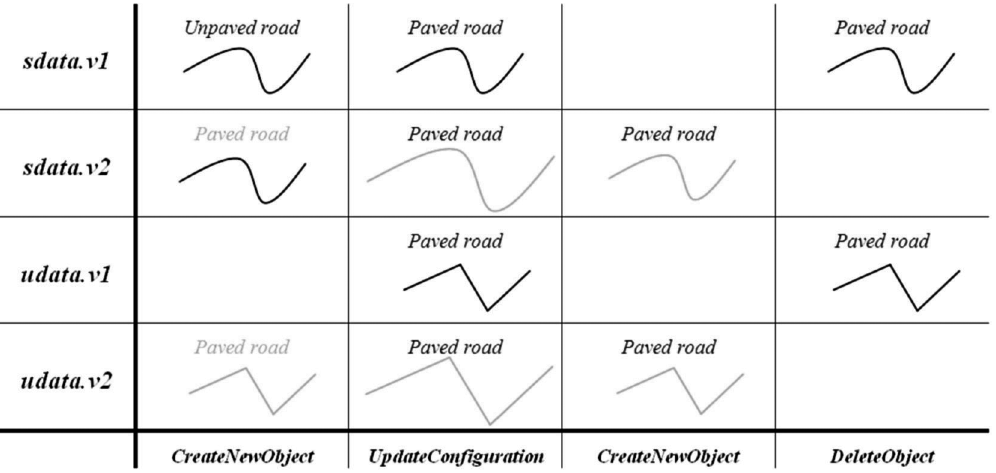
Fig. 5. Examples of the relationship between type of object change and type of object